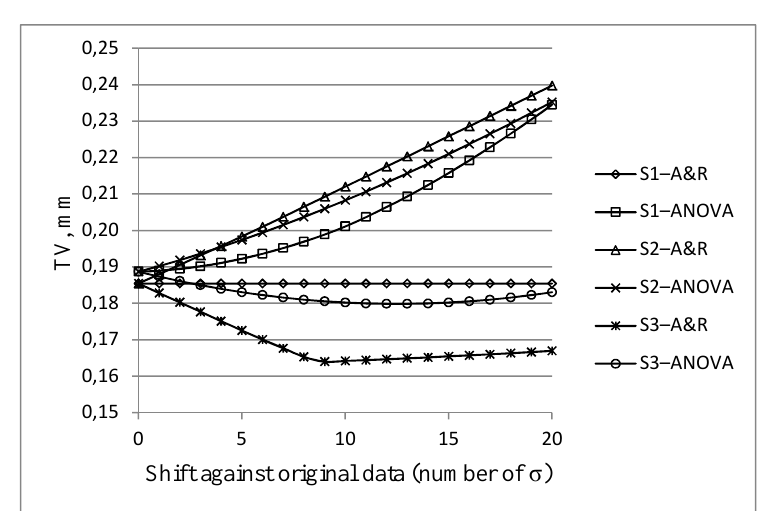
Figure 3 Changes of total variation in the individual simulations depending on the shift of measured